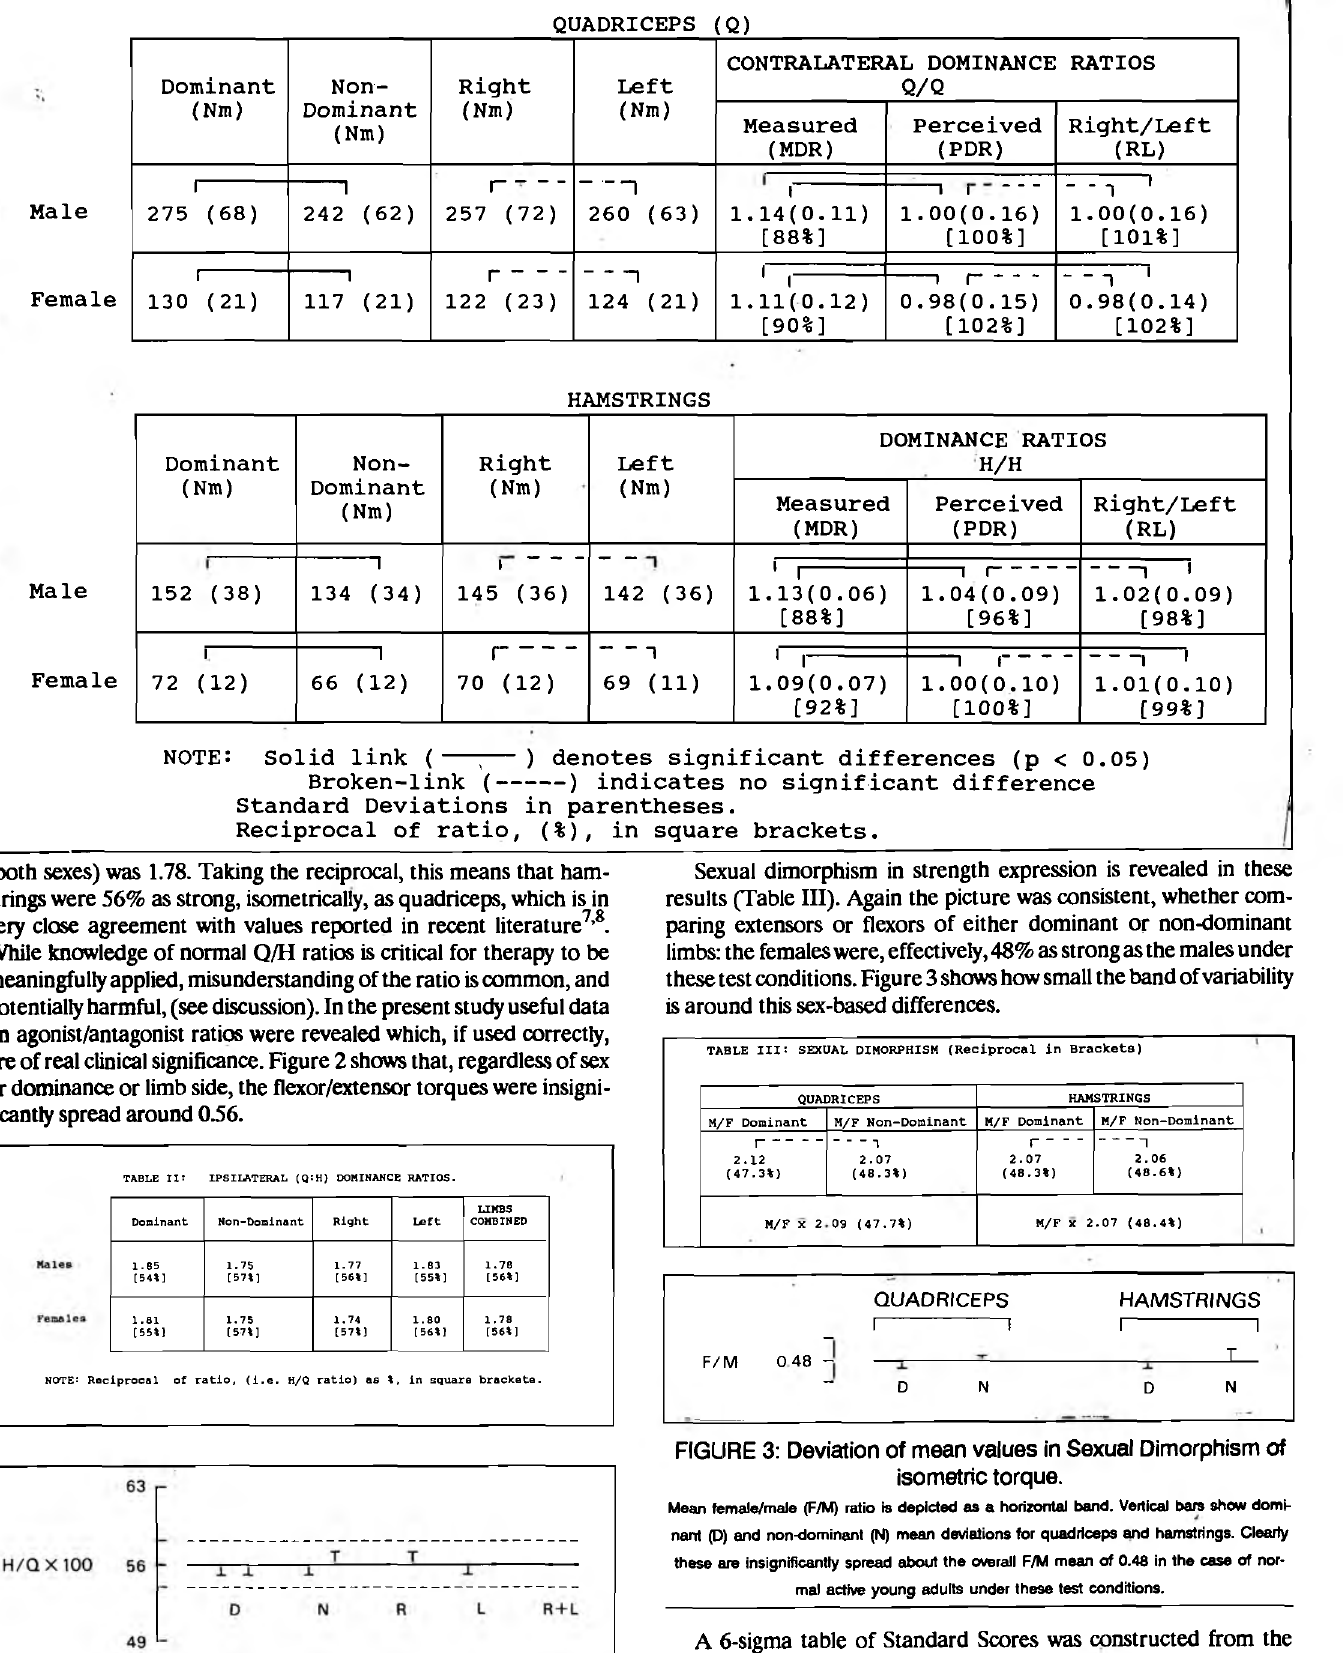
FIGURE 2: Deviation of mean values in H/Q Ratios Dominant (D); non-dominant (N); right (R); left (L) and combined right and left (R + L) flexor-to-extensor ratios, about the overall mean value of 56. Left-most value in each pair is male; right value in each pair is female